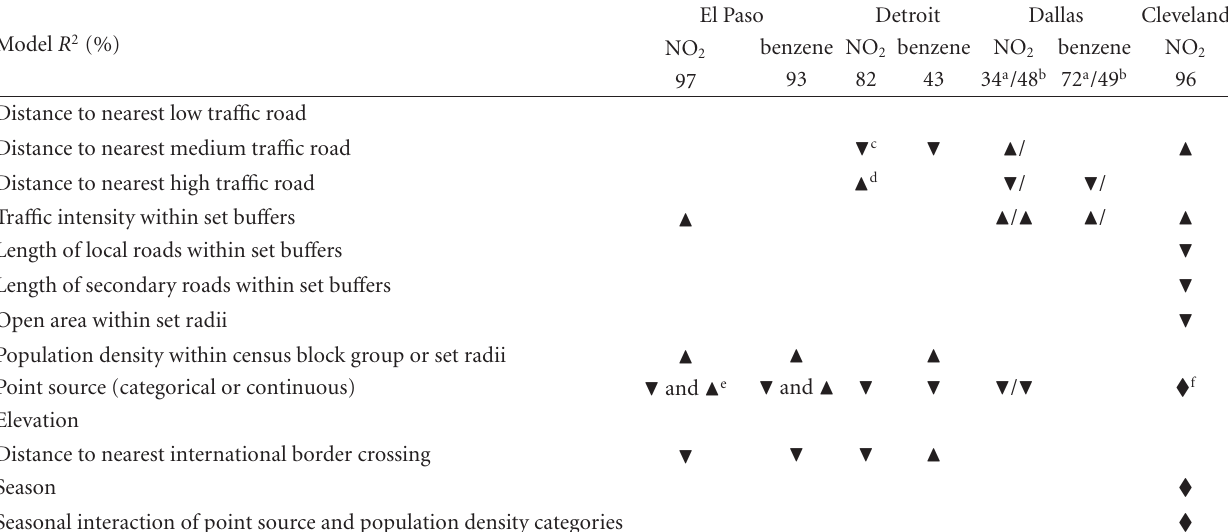
Table 3: Model R 2 and significant variables (5% level) in NO 2 and benzene